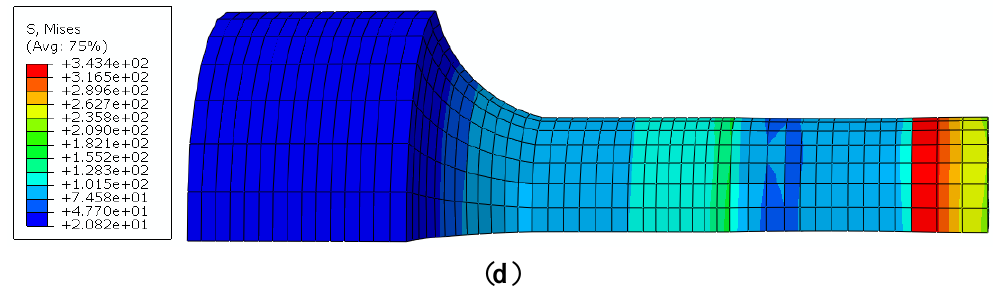
Figure 6. Finite element simulations of creep in a welded 9Cr-1Mo specimen subjected to an applied stress of 200 MPa and at a temperature of 600 °C: ( a ) maximum principal strain; ( b ) displacement along the axis of the specimen; ( c ) von-Mises stress in the cross section of the specimen; and ( d ) the stress distribution at the surface of the specimen.